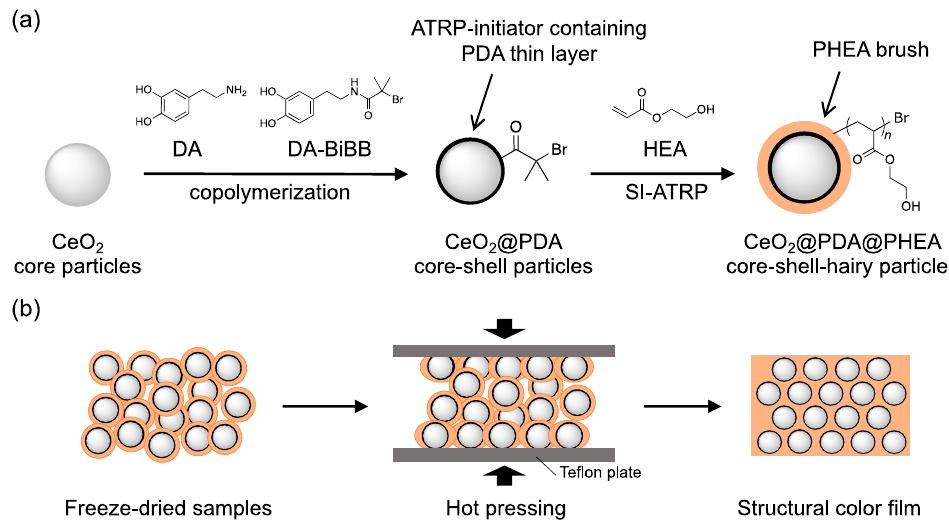
Figure 1. ( a ) Preparation of CeO 2 @PDA core–shell and CeO 2 @PDA@PHEA core–shell-hairy particles. ( b ) Schematic diagram of the preparation of the structural color film by the hot-press method.